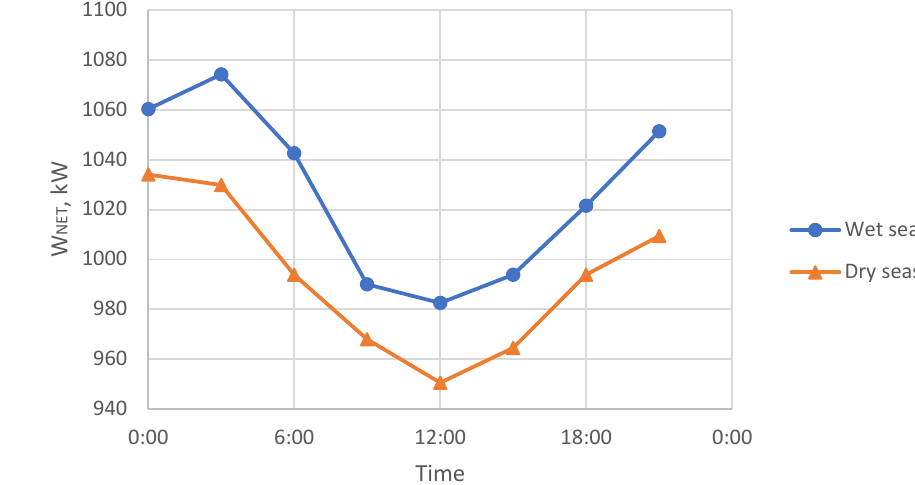
Figure 8. Weather sensitivity analysis to power output.